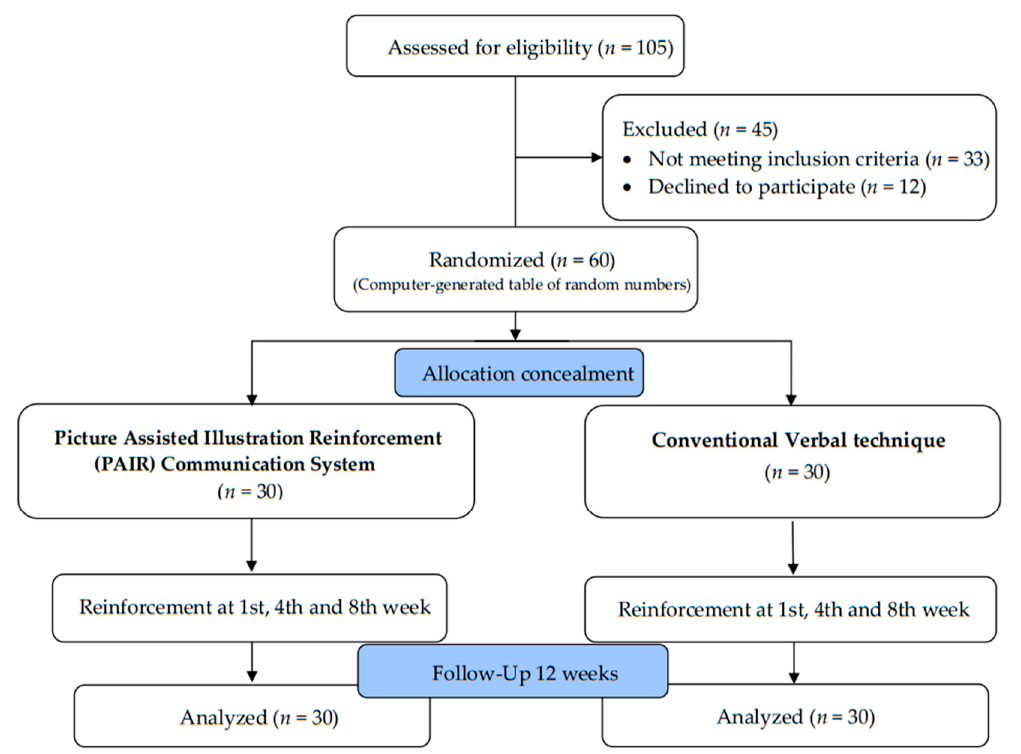
Figure 2. Consolidated Standards of Reporting Trials (CONSORT) diagram.